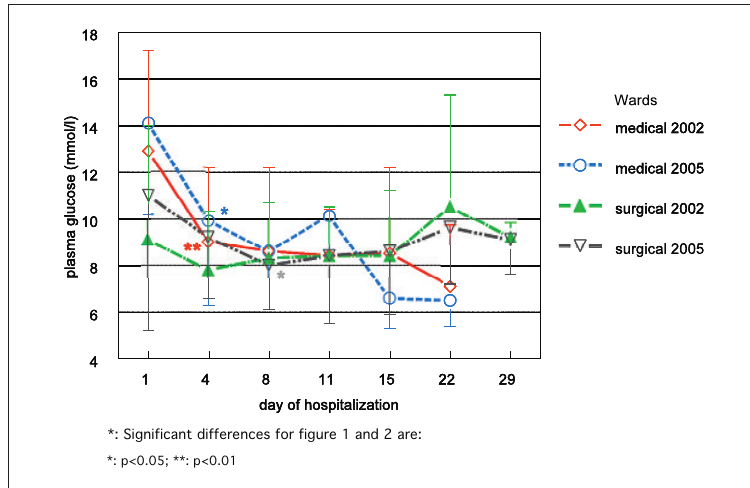
respective prevalence was 56% (n.s.). In 63% of the measurements in all three ICUs the values were above 6.8 mmol/l. Plasma glucose concentration in patients of medical and surgical wards during hospitalisation in 2002 and in 2005. Abbreviations see table